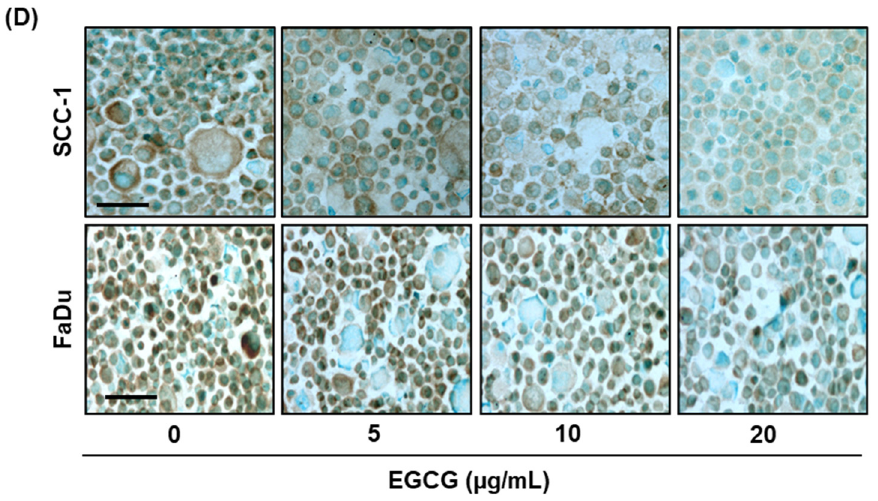
Figure 2. Treatment of SCC-1 and FaDu cells with EGCG decreases the levels of 5-mC in a dose- and time-dependent manner. Dot-blot analysis of 5-mc in DNA, extracted from various groups treated with or without EGCG in both cell lines ( A ). The intensity of individual dots was measured by densitometry in SCC-1 ( B ) and FaDu ( C ), and levels of 5-mc are presented in terms of relative density of dot blots as means ± S.E.M in different treatment groups, n = 3. Significant difference versus non-EGCG-treated controls. The effect of EGCG on DNA methylation in SCC-1 and FaDu cells was reconfirmed by immunostaining of 5-mc using an anti-5-mc antibody. Cells were counter stained with methylene green ( D ). Scale bar = 20 μ M.